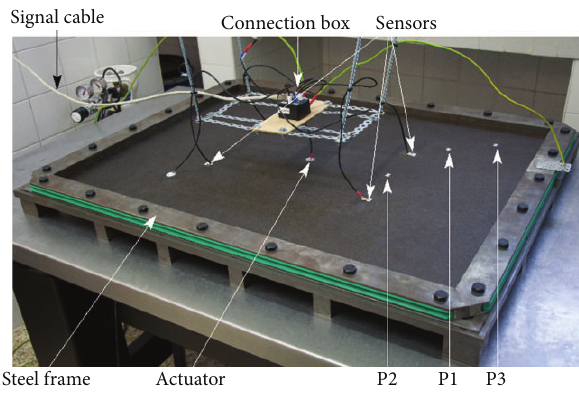
Figure 1: Plate under study and experimental arrangement.